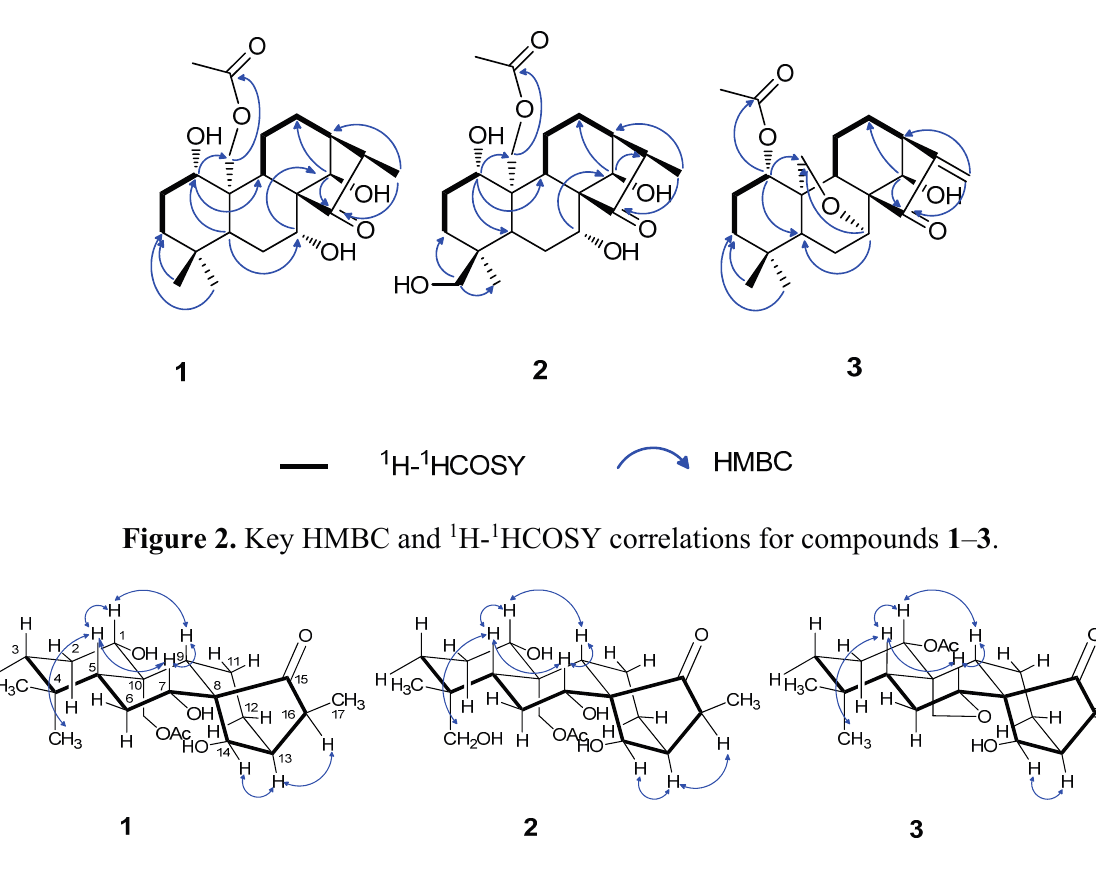
Figure 3. Key ROESY correlations for compounds 1 – 3 .